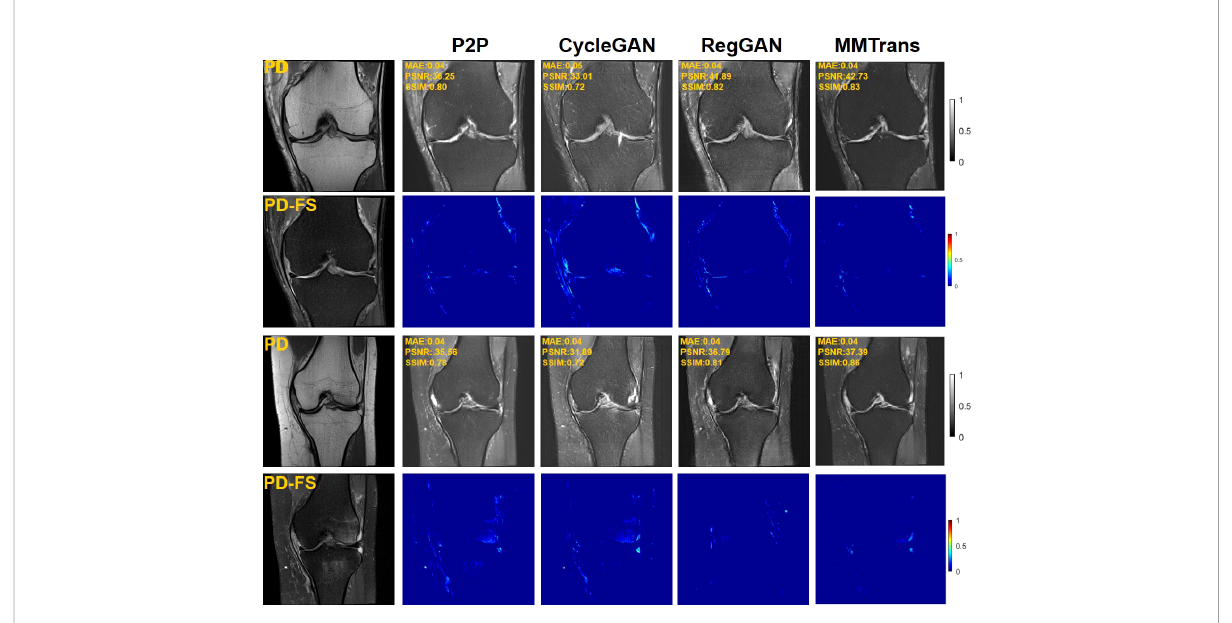
FIGURE 4 Qualitative results of different translation methods from PD to PD-FS using public fastMRI dataset, displaying translation images and corresponding error